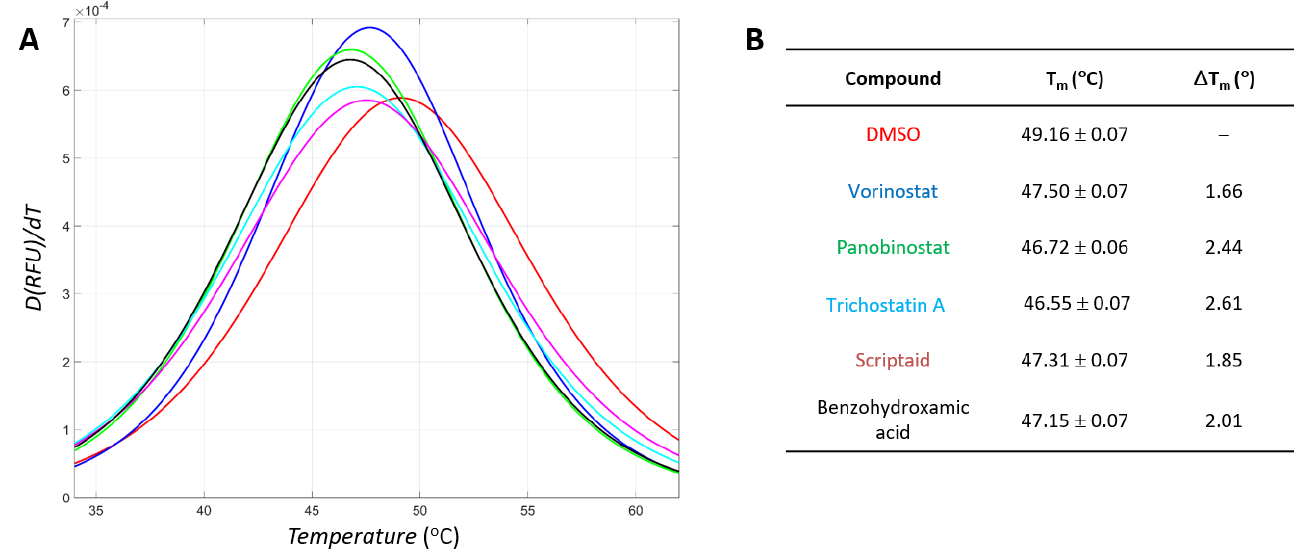
Figure 3. Profiles of differential scanning fluorimetry with tyrosinase and hydroxamate-containing inhibitors. Identical colors are used for the profiles and information for each compound. ( A ) Profiles. Derivatives of the relative fluorescence unit (RFU) by temperature ( D(RFU)/dT ) were constructed in the range of 34 ◦ C to 62 ◦ C. ( B ) Calculated values. Means and standard deviations were obtained from three repeated independent